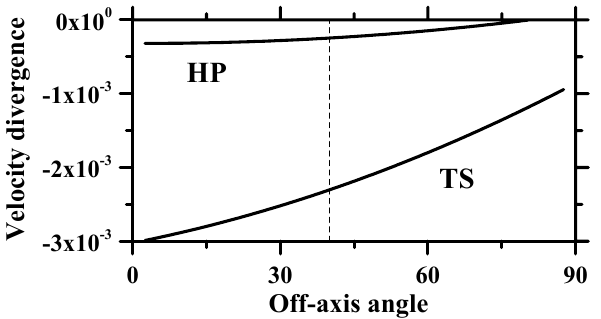
Fig. 2. Normalized velocity divergence in the inner heliosheath just downstream of the TS and along the inner side of the HP as func- tions of the off-axis angle. The angle values below the dashed line corresponds to the region shown in Fig.